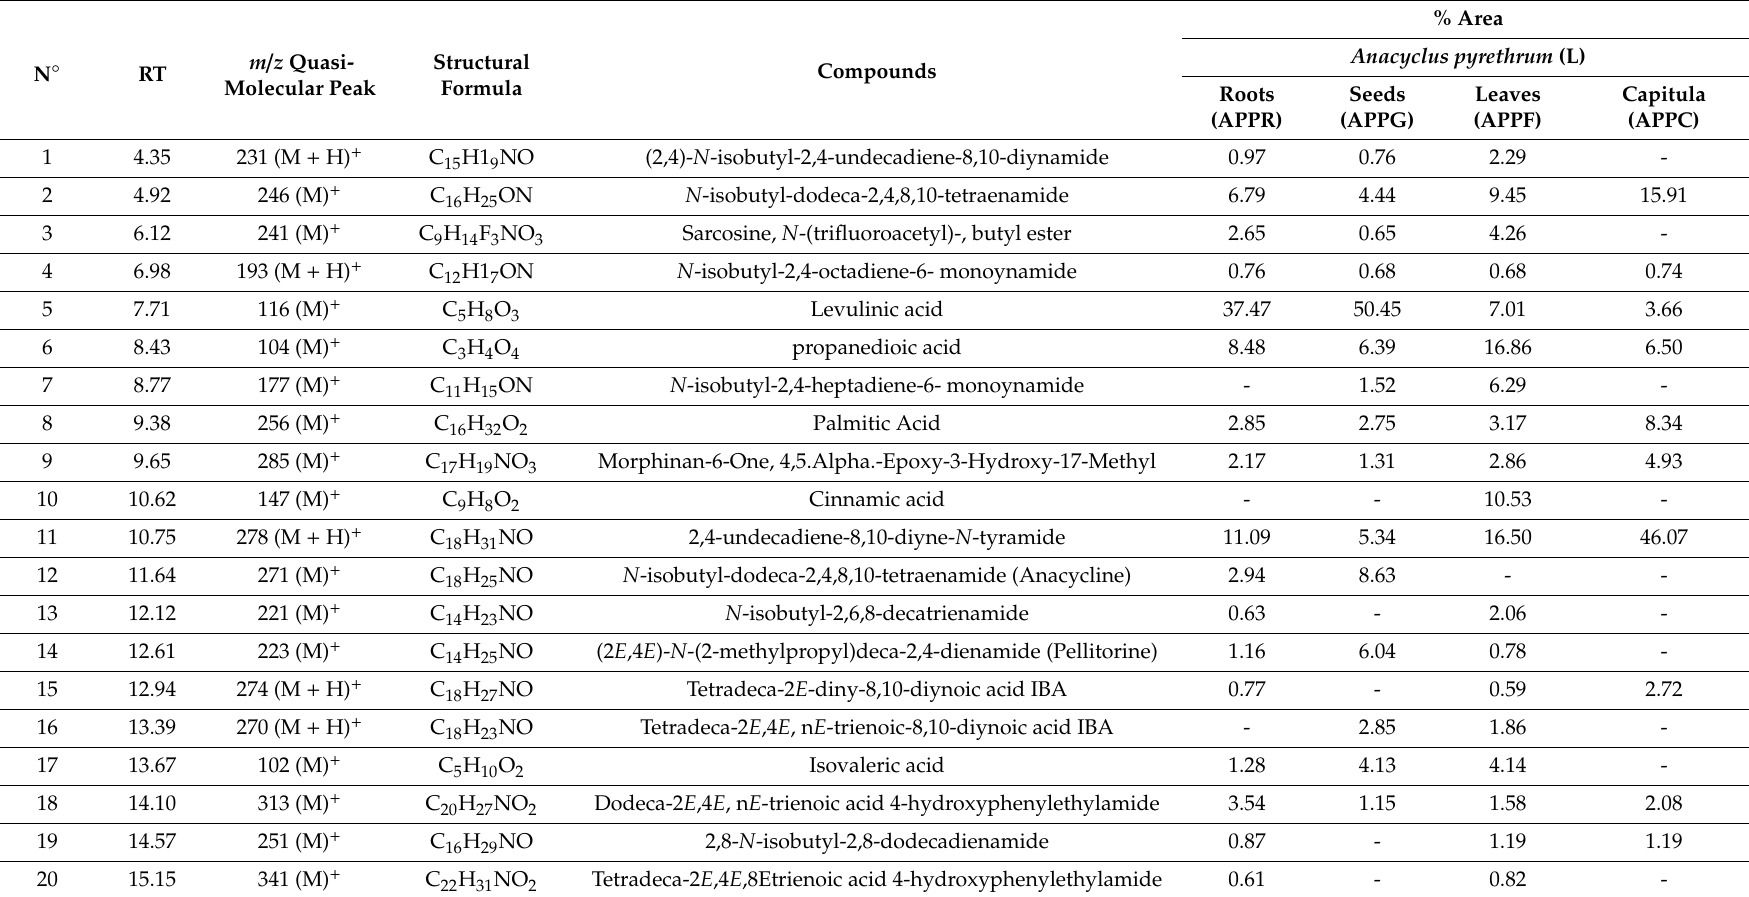
Table 5. Chemical composition of di ff erent parts (roots, seeds, leaves, and capitula) of A. pyrethrum